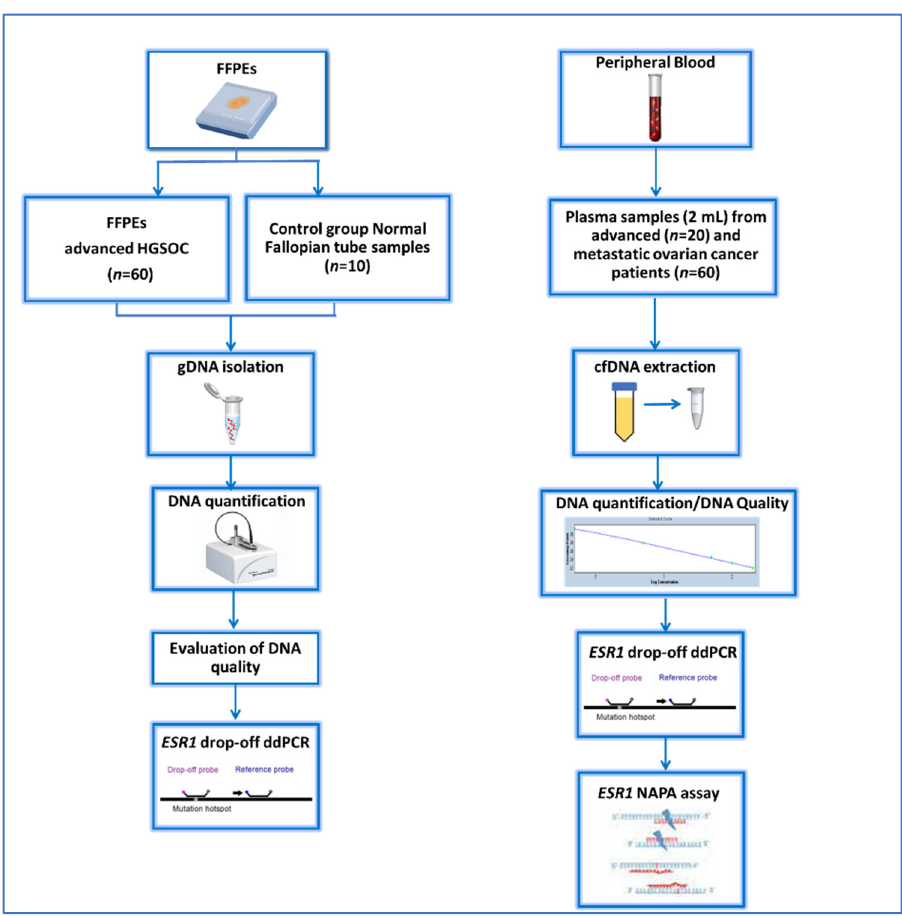
Figure 1. Schematic flowchart of the